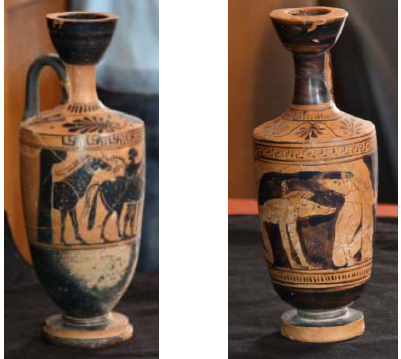
Fig. 1. Photos of the two lekythoi, with the adventures of Odysseus carved on their